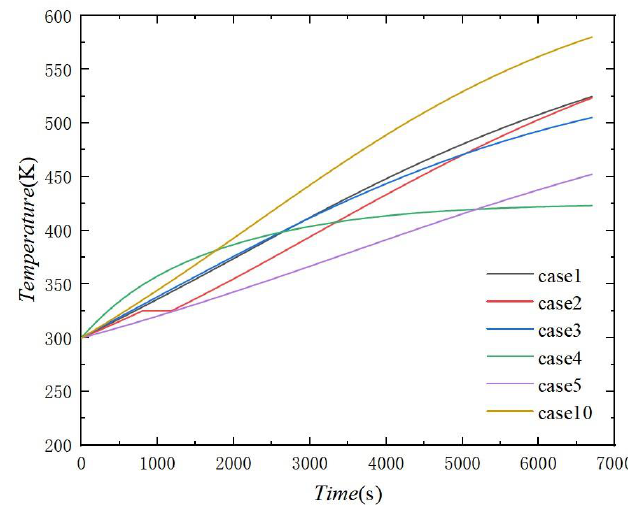
Figure 16. Temperature of accessory 2 with a single thermal protection measure.